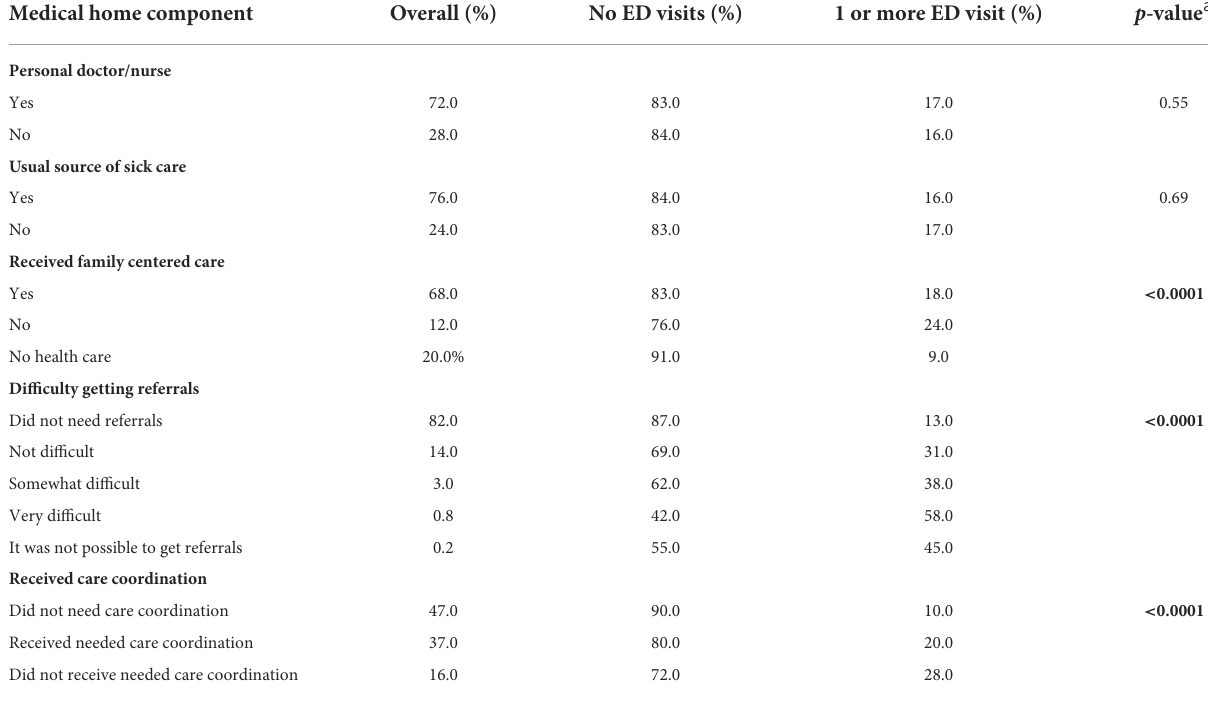
TABLE 2 Association between medical home component and reports of hospital emergency room